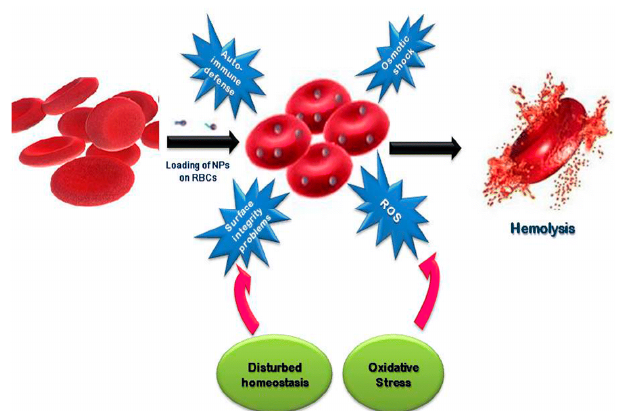
Figure 44. Hemolysis is caused by the binding or encapsulation of nanoparticles (NPs) in red blood cells (RBCs) leading to the generation of ROS, oxidative stress, and disturbed homeostasis as a result of osmotic shock and surface integrity problems. Reproduced from [320] with permission of Springer Nature.